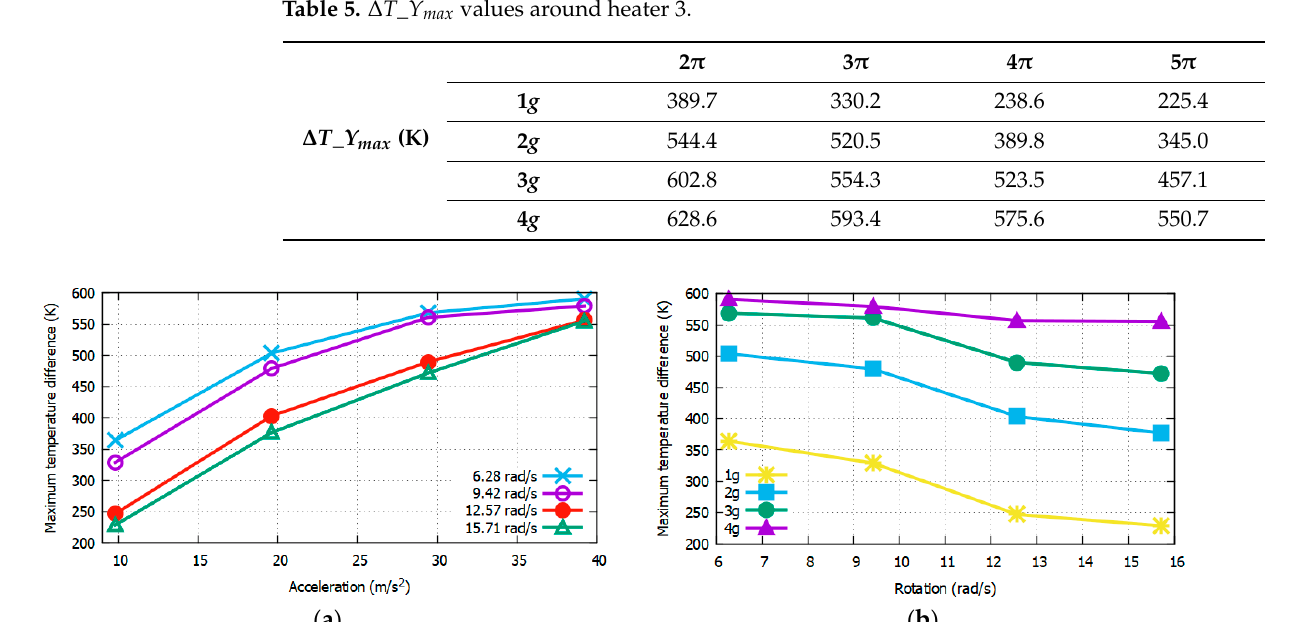
Figure 14. Δ T max at X sensors w.r.t acceleration ( a ) and rotation ( b ) at varying rotation values by using CO 2 as the gas medium.